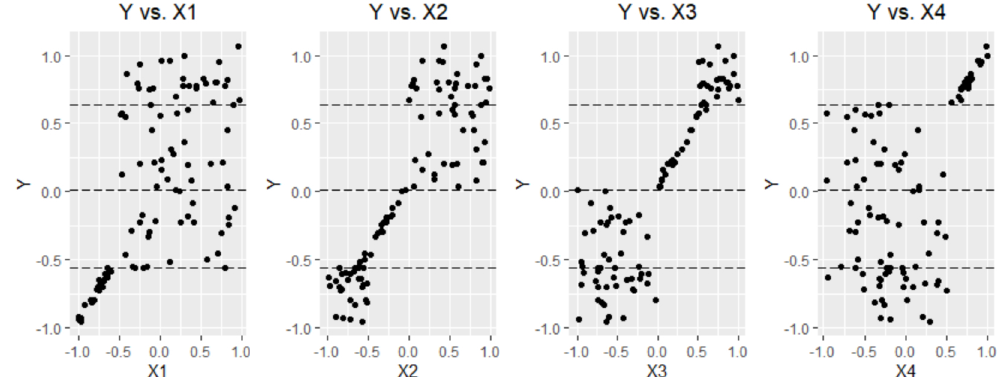
Figure 5. Plots of the simulated data Y vs. X 1, X 2 , X 3 and X 4. G1, G2, G3 and G4 are divided by the dashed lines in each